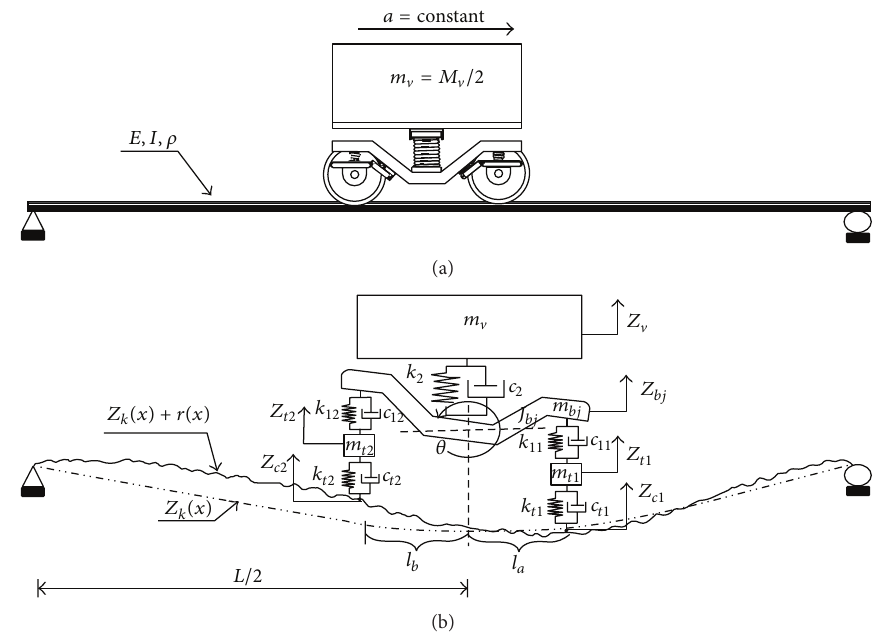
Figure 1: (a) Bogie moving on a railway bridge with constant acceleration; (b) bogie-bridge model with 5 degrees of freedom.